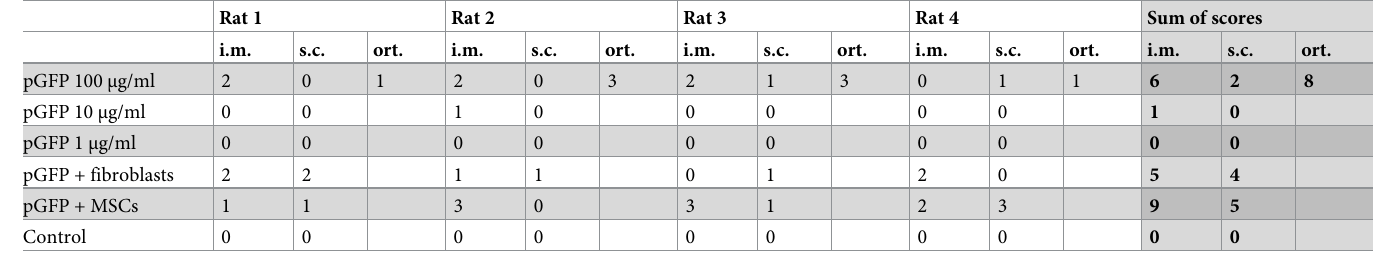
Table 3. Scoring of transgene expression at the different implant